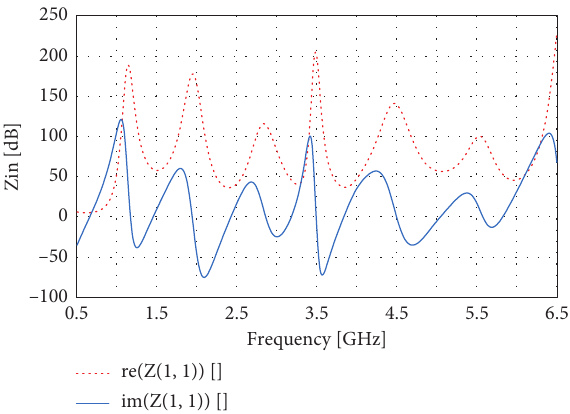
Figure 18: The graph of Z